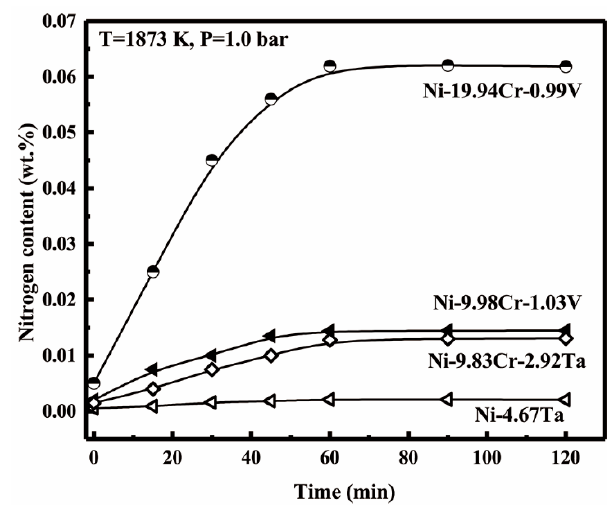
Figure 2. Variation of nitrogen content with time in nitrogen dissolution experiments.